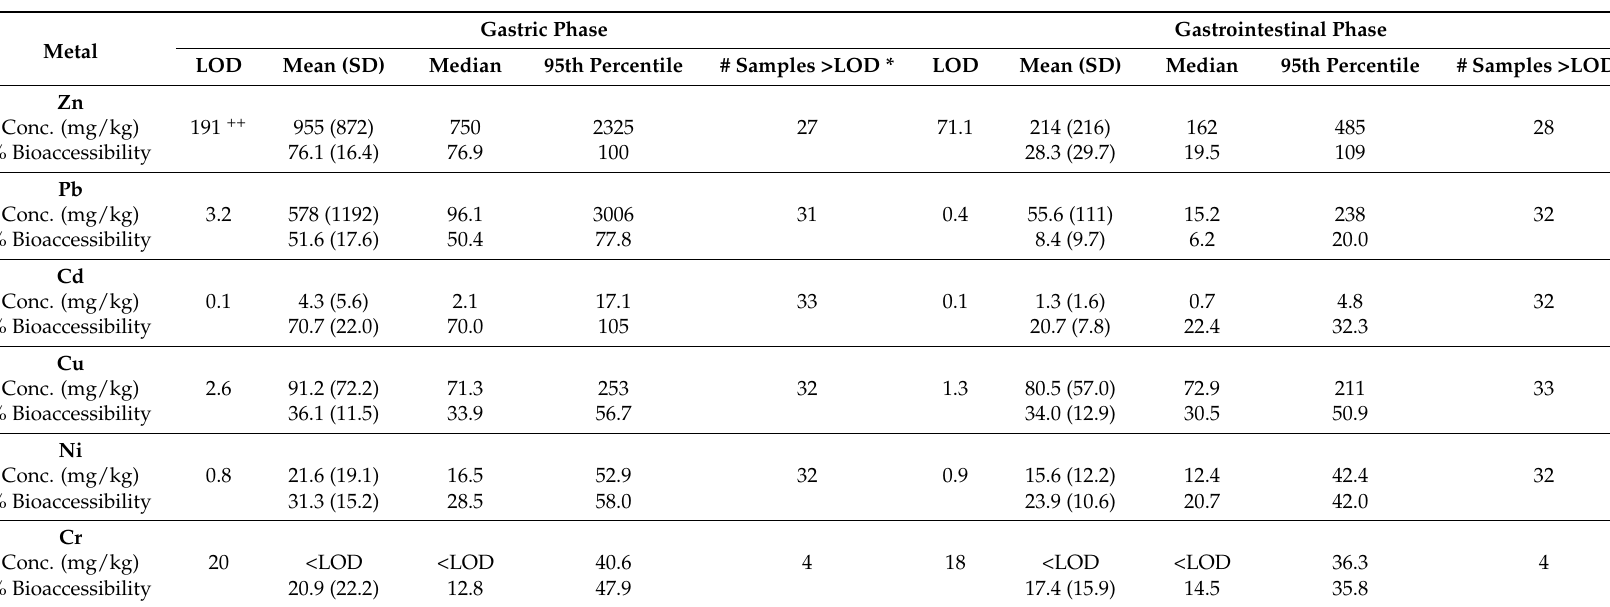
Table 3. Bioaccessible metal concentration (mg/kg) and percent bioaccessibility for house dust samples from 33 Montreal homes (<80 µ m fraction), comparing results for the gastric (G-alone) and gastrointestinal (GI) PBET extraction phases (SD = Standard deviation; LOD = Limit of